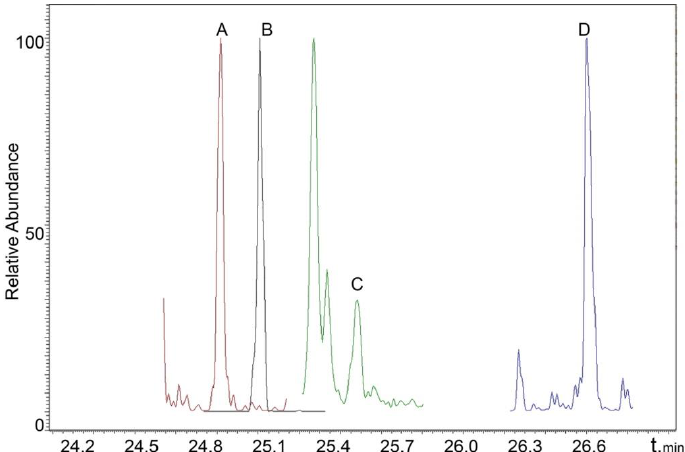
Figure 3. MRM chromatogram of a real male sample: A—DHT; B—testosterone; C—methyltestosterone (IS).